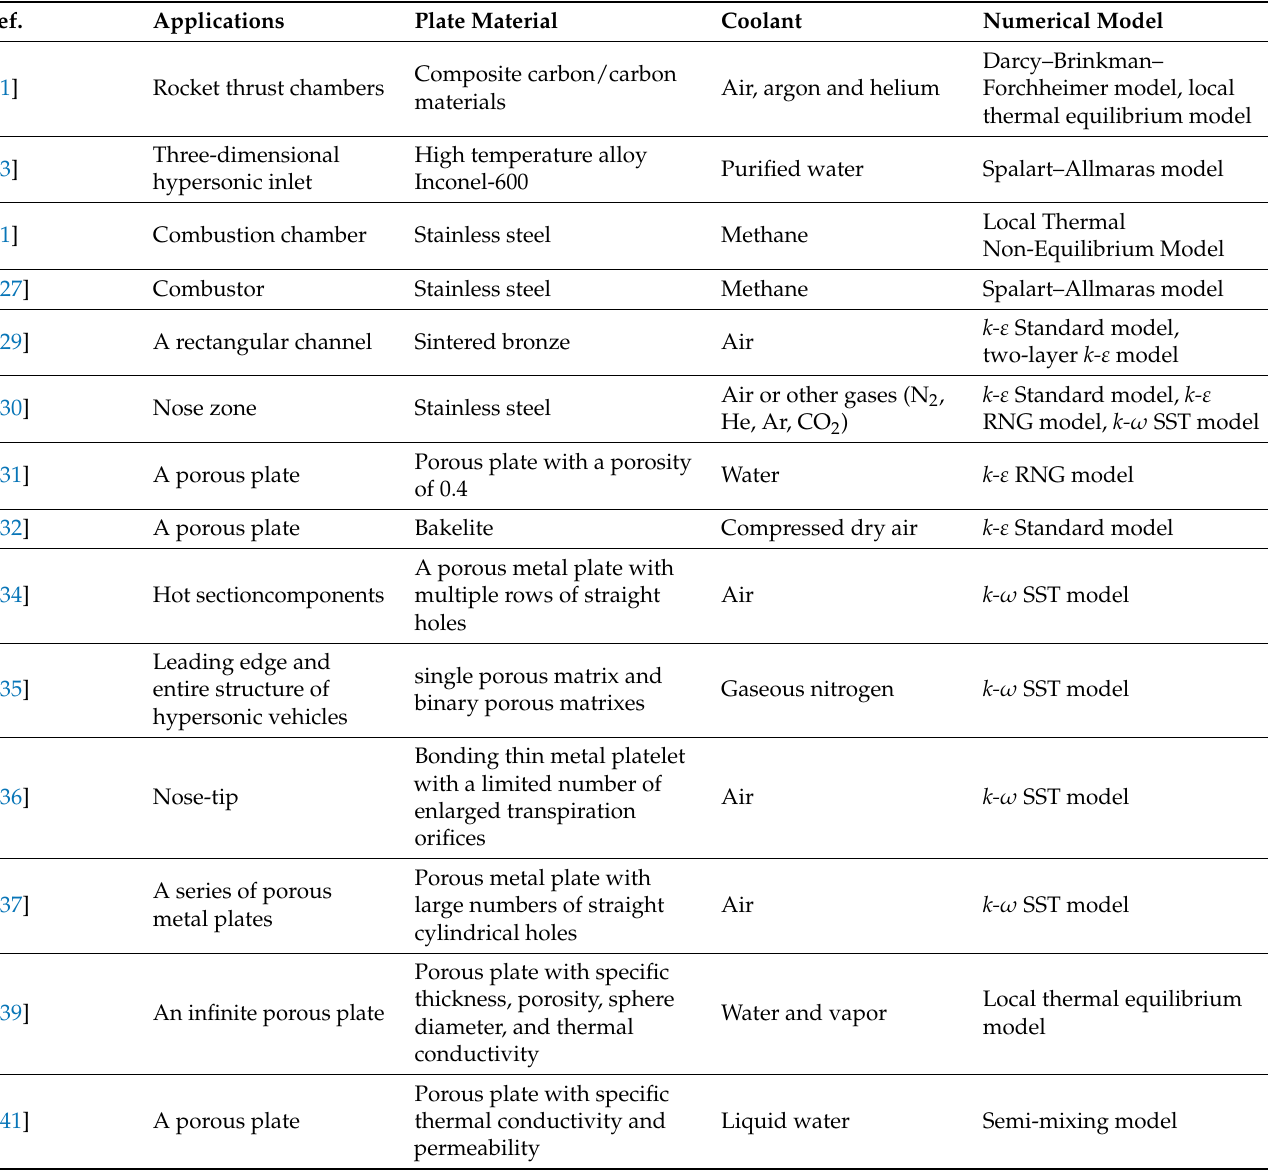
Table 4. Literature on different numerical models used in transpiration